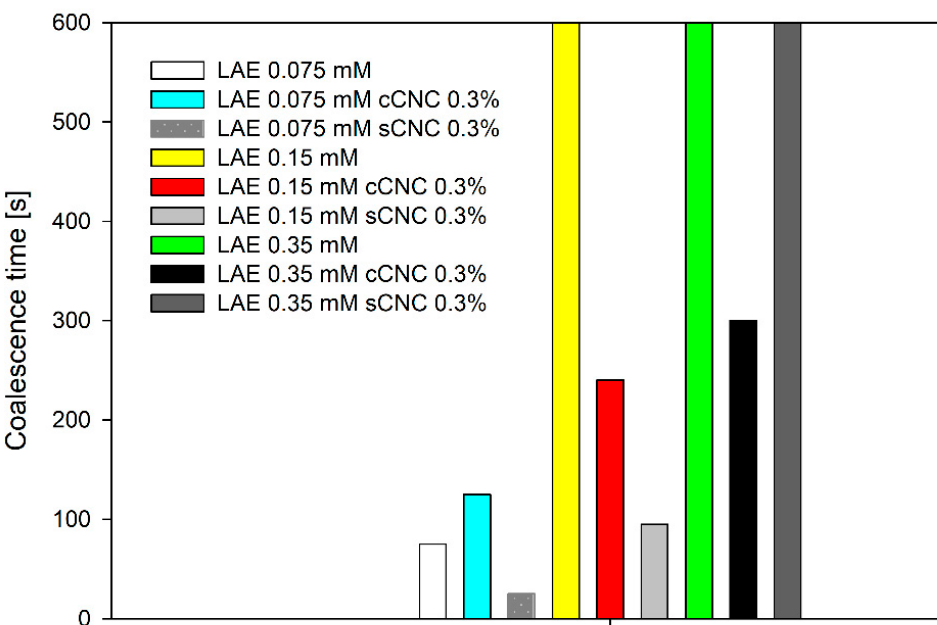
Figure 6. The thin films’ lifetime after equilibration and the pressure step of 100 Pa. For pure LAE, 0.15 mM and 0.35 mM LAE and 0.35 mM LAE and sCNC, film lifetime exceeded 600 s.